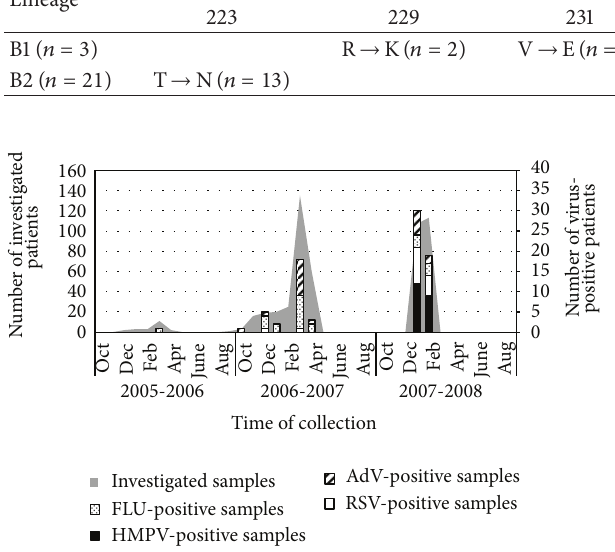
Table 6: Lineage-specific amino acid substitutions in the HMPV F gene between positions 209 and 353. Lineage